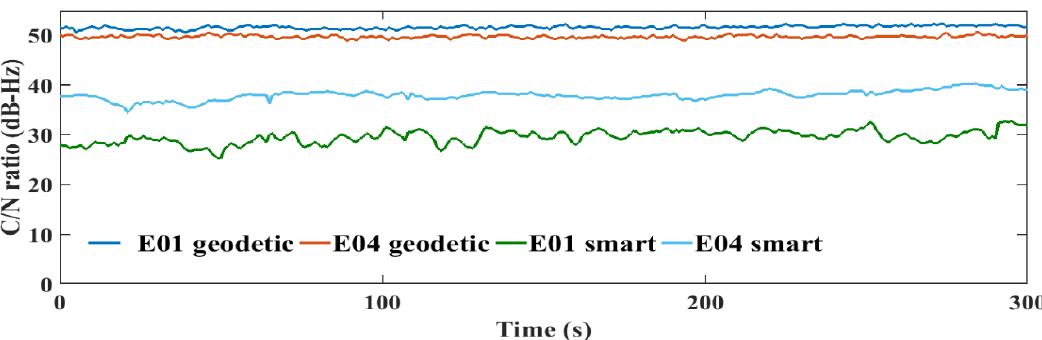
Table 2. Geodetic receiver and smartphone DGNSS